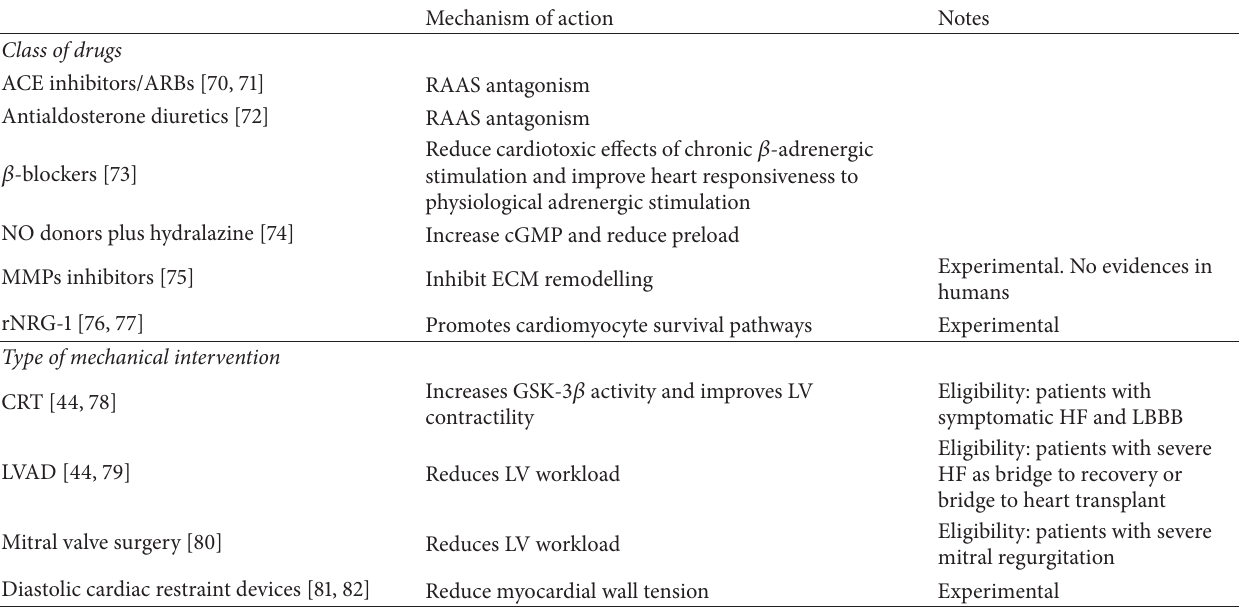
Table 2: Therapies capable of inducing reverse remodelling.